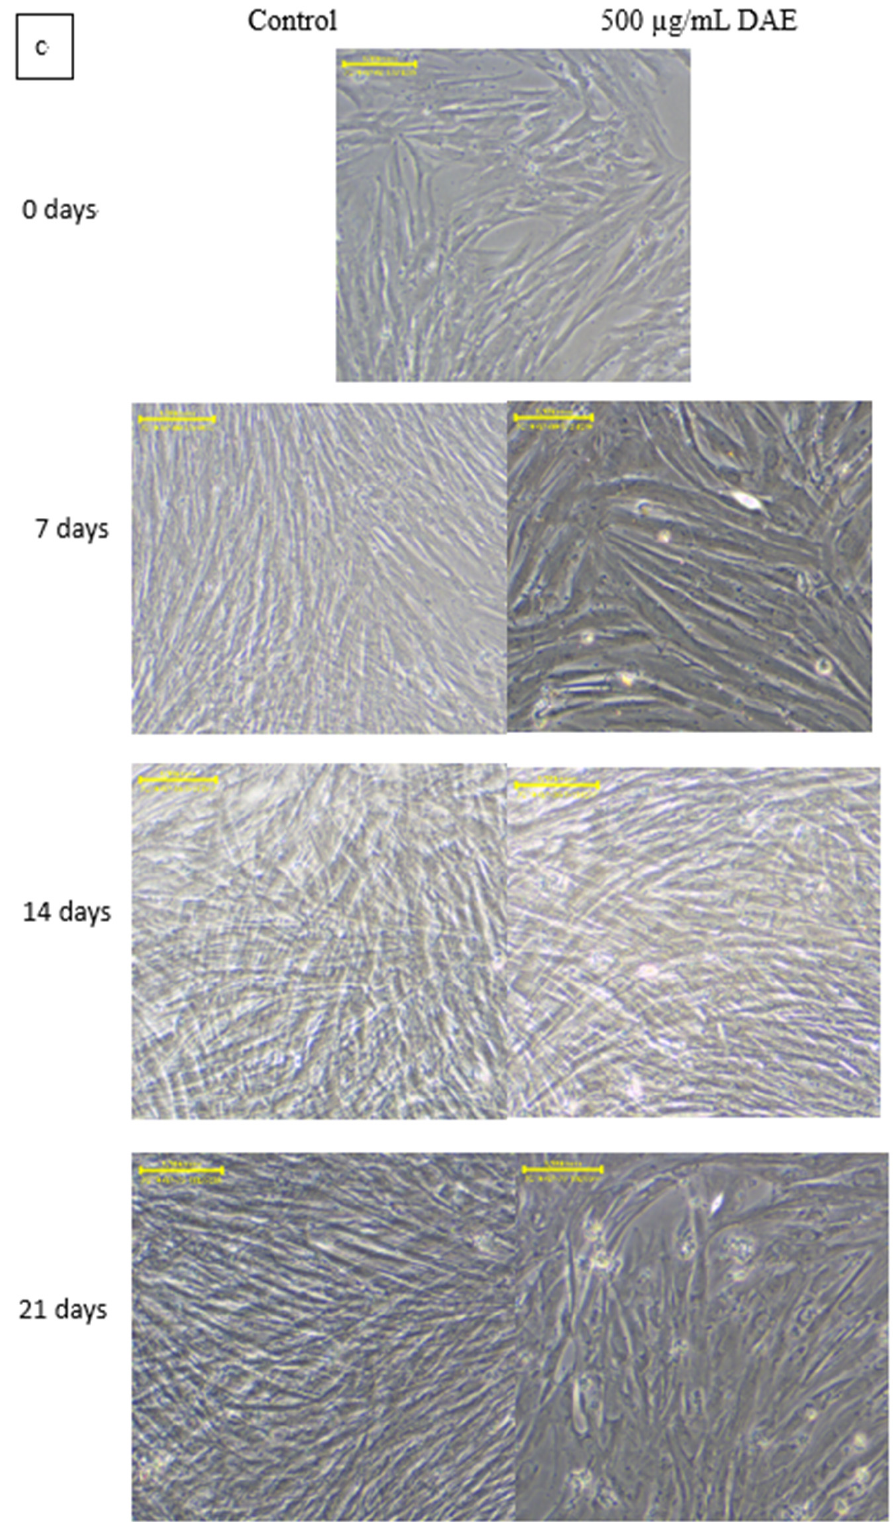
Figure 2. The proliferation of PDLSCs treated with different concentrations of DAE ( a ), and cell viability ( b ), * p < 0.05 compared each other. Values are expressed as mean ± SD (n = 3). The cellular morphology changes before and after treatment with 500 µg/mL DAE ( c ); scale bar = 100 µm.